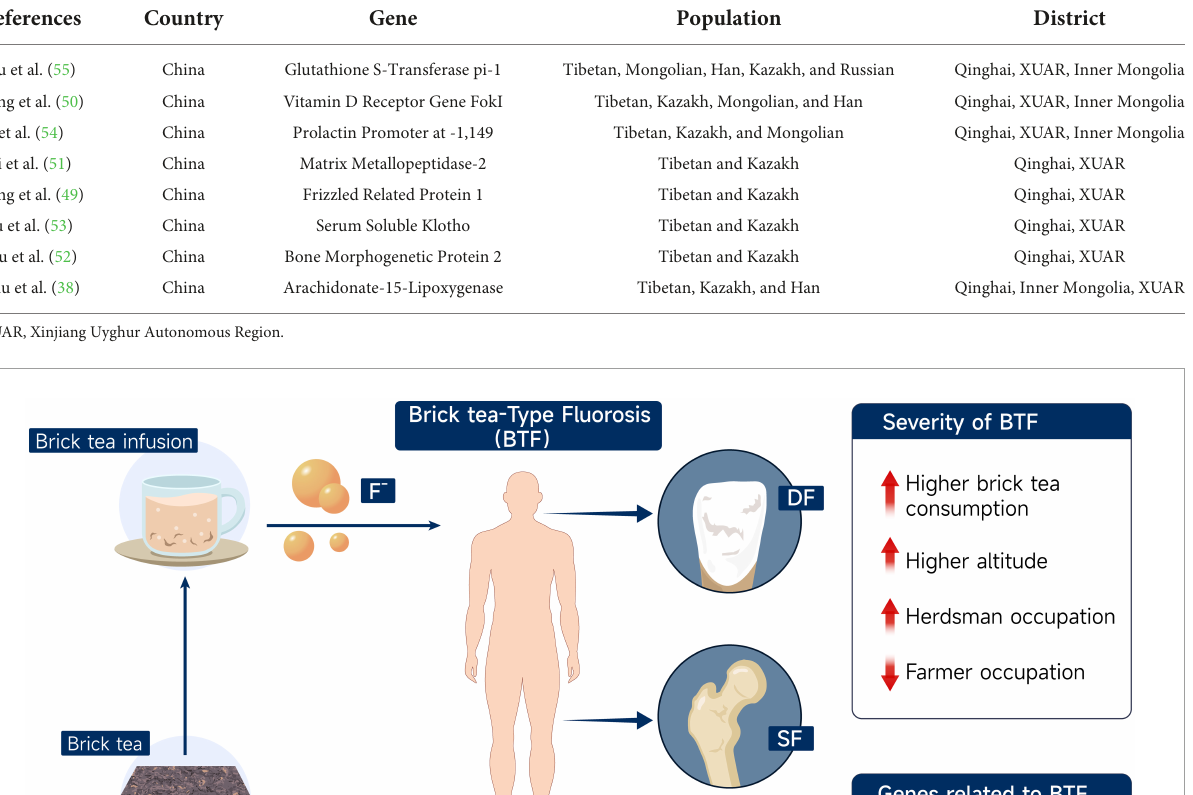
TABLE 7 Genetic studies associated with brick tea-type fluorosis susceptibility.